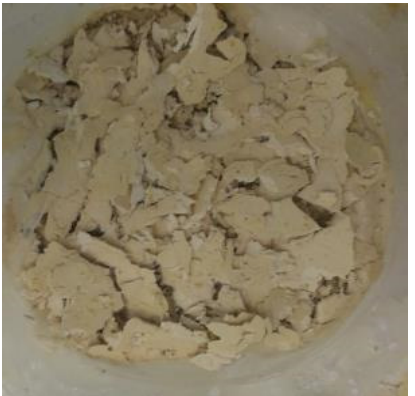
Figure 11. Complete degradation of the NBR-CW coating exposed to 30% CH 2 O 2 for 120 days.